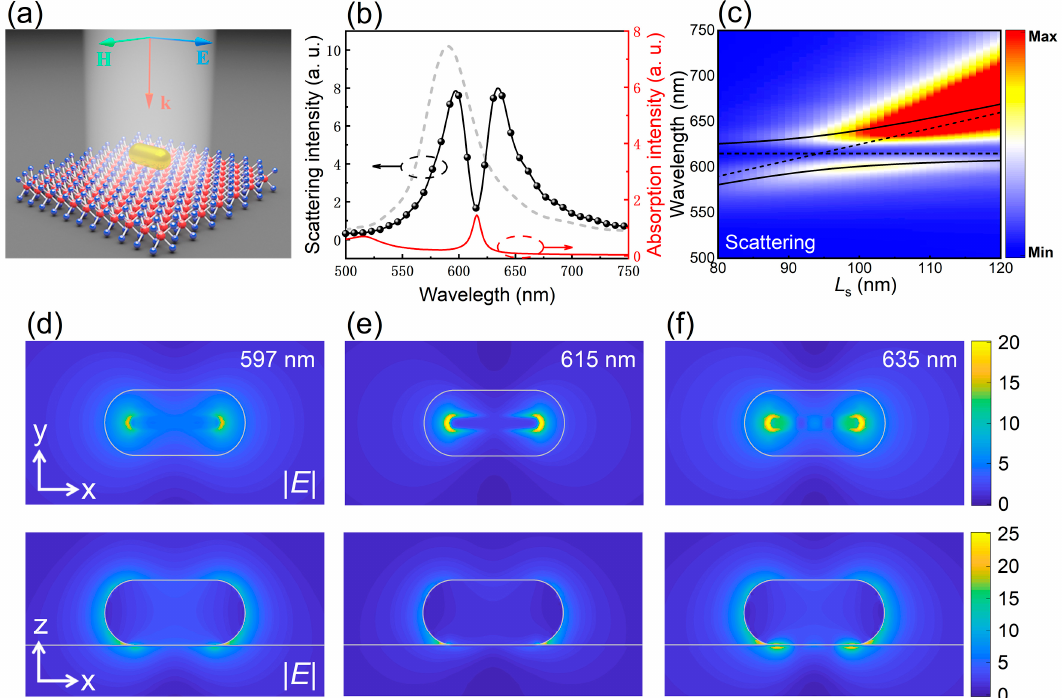
Figure 4. Strong coupling between the dipole mode in a single GNR and the excitons in a monolayer WS 2 . ( a ) Schematic showing the excitation of a single GNR placed on a monolayer WS 2 by using plane wave. ( b ) Scattering spectrum (black solid curve) calculated for a GNR resonant with the exciton resonance of the monolayer WS 2 . Additionally, shown are the scattering spectrum of the GNR in the absence of the monolayer WS 2 (dashed curve) and the absorption spectrum of the monolayer WS 2 (red solid curve). ( c ) Two-dimensional scattering spectra calculated for GNRs with different lengths. The fitting results based on Equation (2) are also provided. ( d – f ) Electric field distributions in the XY plane (upper panel) and XZ plane (lower panel) calculated for the GNR with L s = 94 nm at different wavelengths of λ = 597, 615 and 635 nm, respectively.